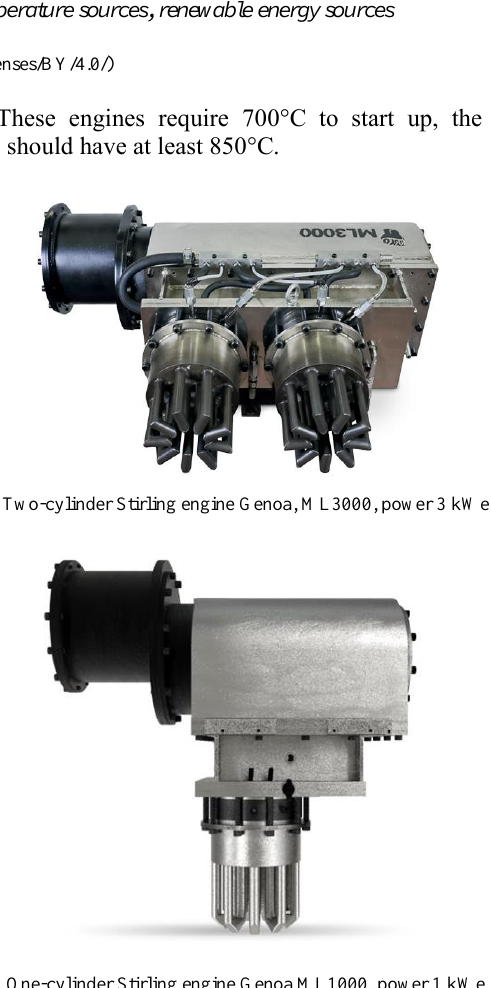
Fig. 2. One-cylinder Stirling engine Genoa ML1000, power 1 kWe [19] Microgen products are based on one cylinder beta type Stirling engine. Available is setup with 1 kW and 2 kW electric power and heat might be generated in an external combustion chamber produced by burning natural gas or solid fuels. These engines belong to group free piston Stir- ling engines. Linear generator converts motion of piston on electric energy. This engine starts from about 180°C (work- ing medium temperature). In Fig. 3 a view of Microgen Stirling engine has been